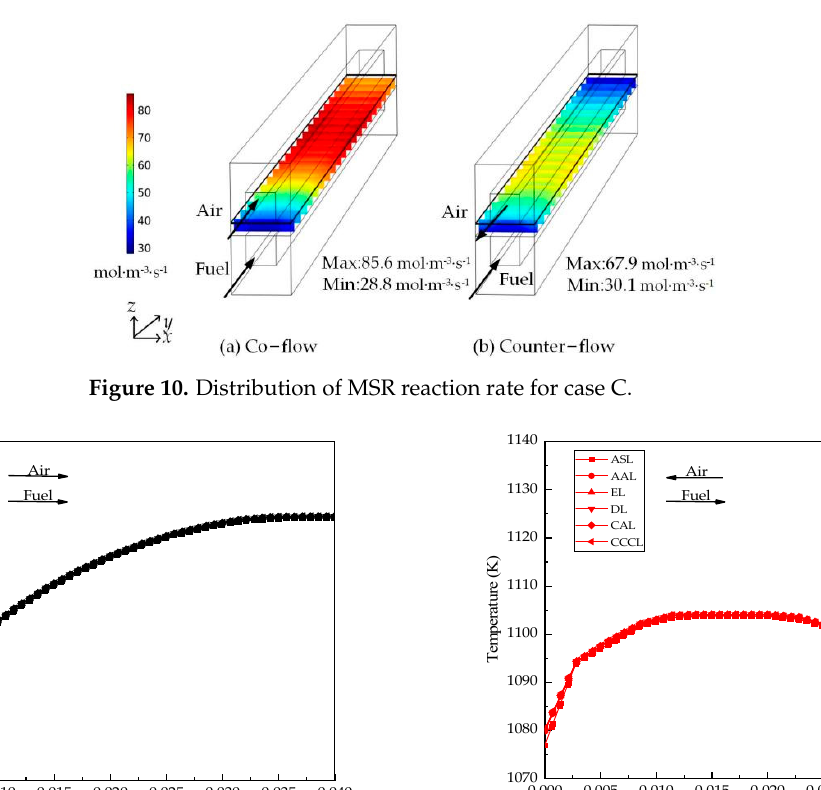
Figure 12. Distribution of temperature gradient of each component along the forward direction of y-axis for case C. ( a ) Co-flow; ( b ) Counter − fl ow. Figure 13 shows the distribution of the first principal stress for case C with different flow arrangements, and Figure 14 shows the distribution of the maximum value of the first principal stress for each component. It is found that the distribution trend of the first